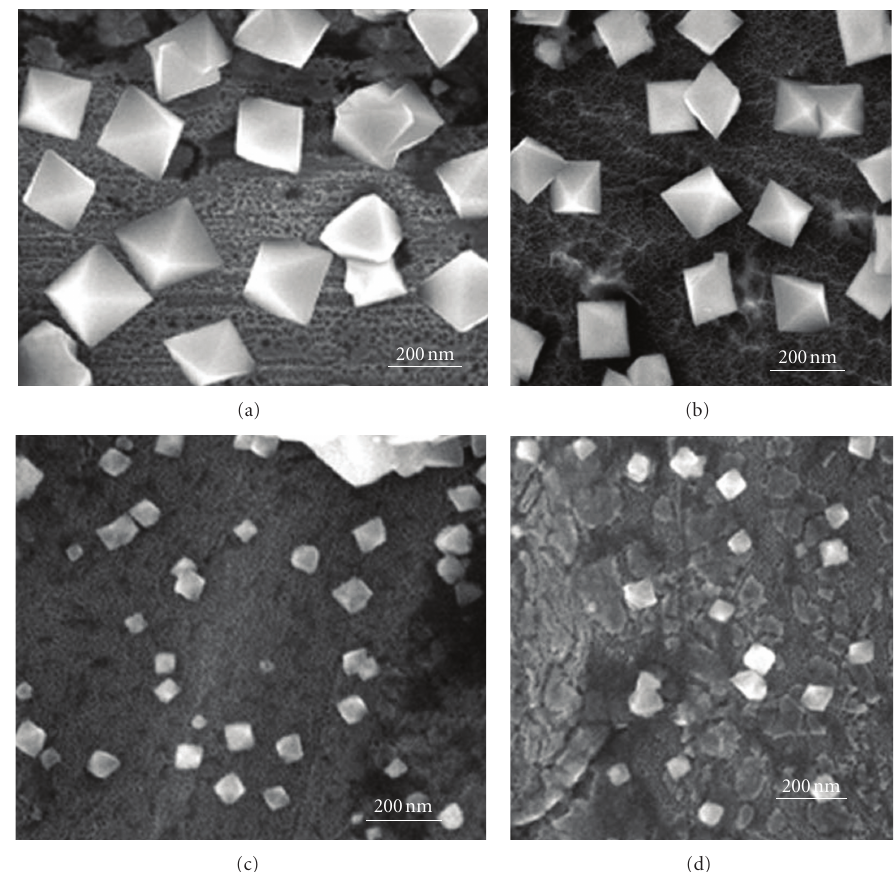
Figure 4: SEM images of the as-deposited specimen at di ff erent bath pH: (a) pH = 8; (b) pH = 9; (c) pH = 11; (d) pH = 12 at − 0.3 V for